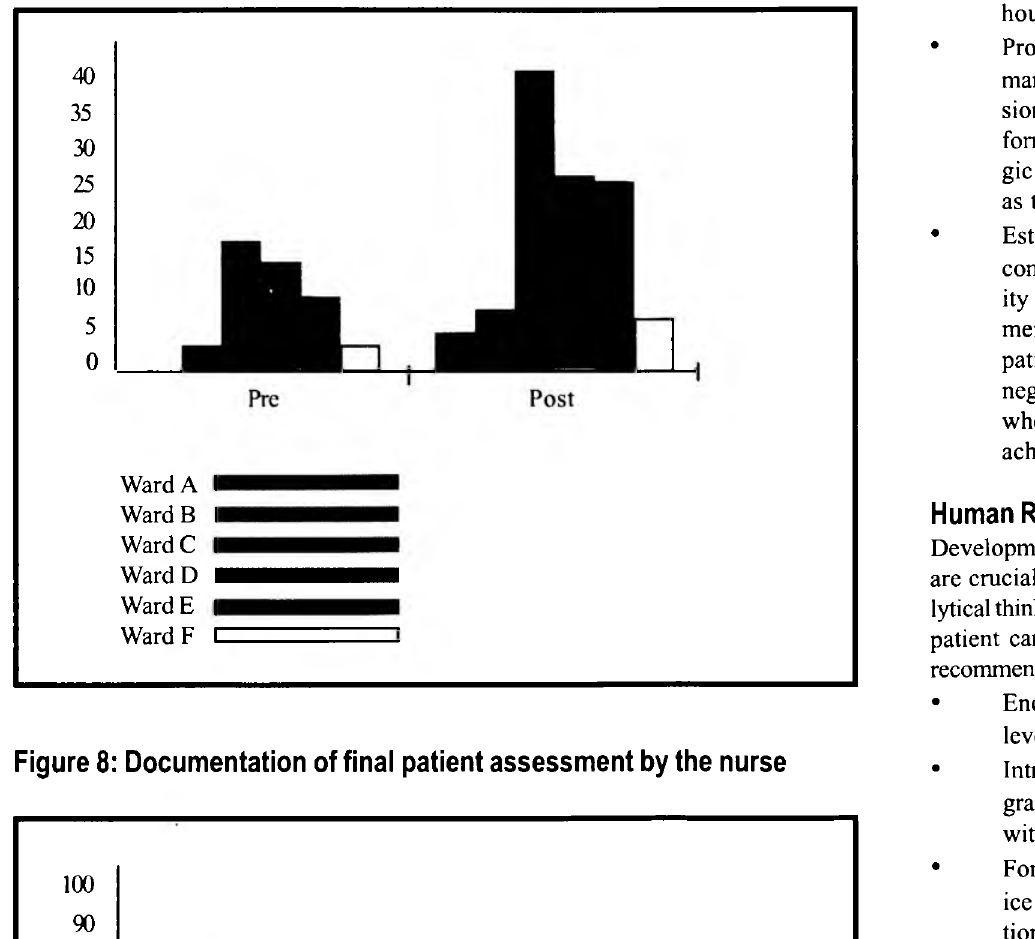
Figure 8: Documentation of final patient assessment by the